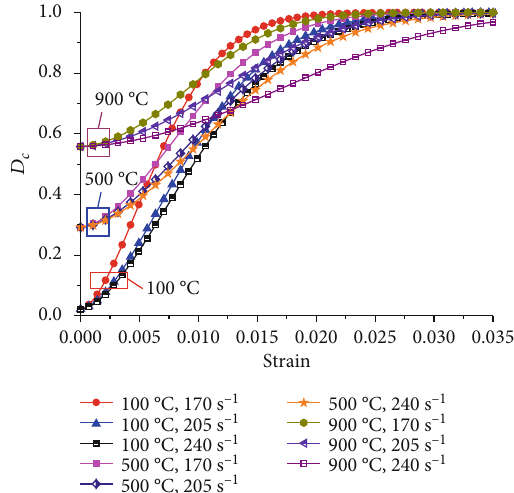
Figure 7: Dynamic damage growth curves of deep sandstone specimen with various strain rates.